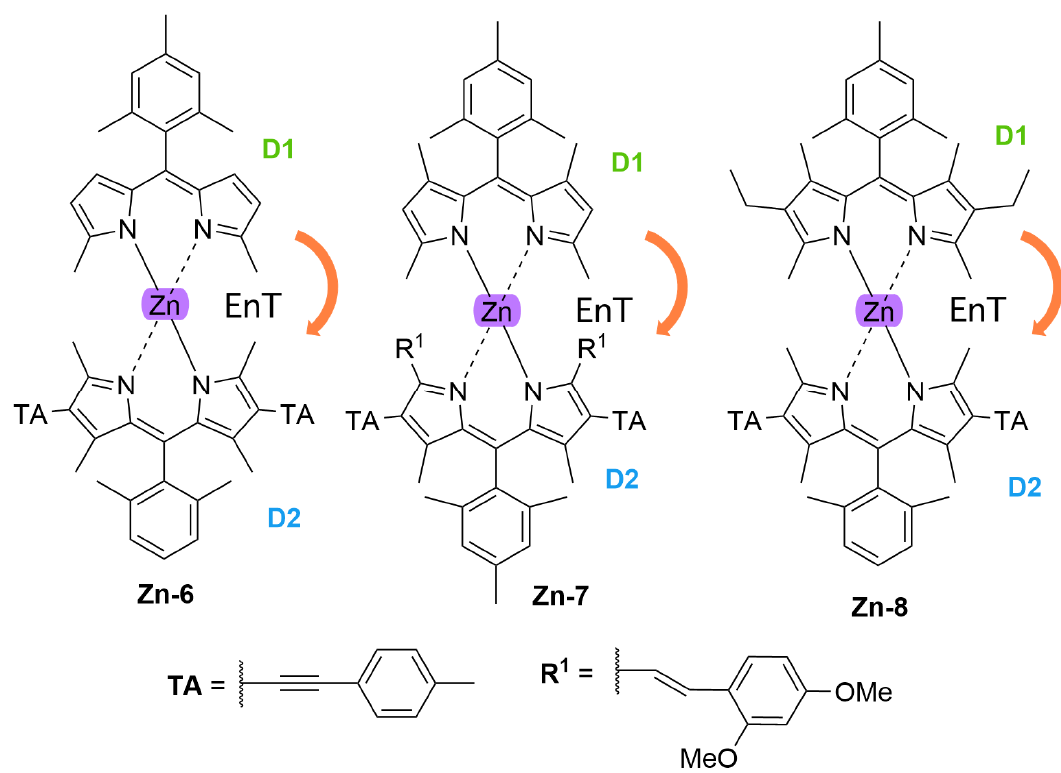
Figure 19. Chemical structures of heteroleptic (dipyrrinato)Zn(II) complexes reported in literature [165,177]. The orange arrow indicates energy transfer (EnT) from the D1 ligand to the D2 ligand.